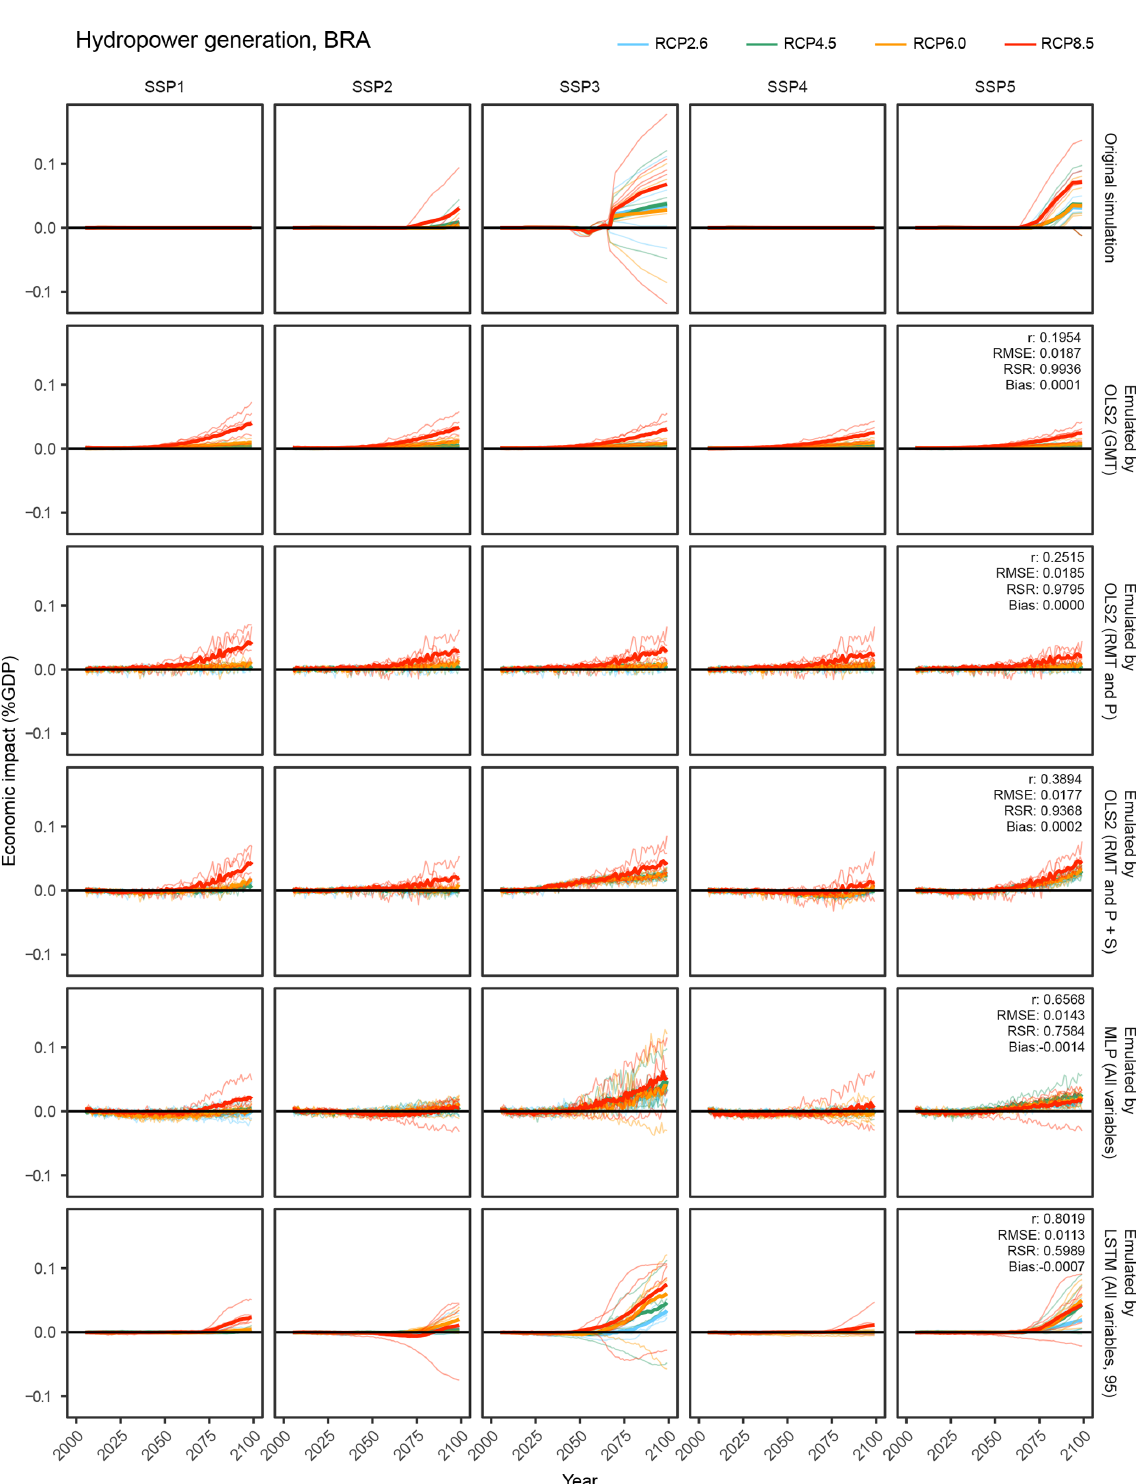
Figure 10. Time-series results of the simulation and emulations for the hydropower generation sector in the Brazil region. OLS2 (GMT): OLS2 with global mean temperature. OLS2 (RMT and P): OLS2 with regional mean temperature and precipitation. OLS2 (RMT and P + S): OLS2 with regional mean temperature precipitation and socioeconomic variables. MLP (All variables): MLP with all the input variables. LSTM (All variables, 95): LSTM with all the input variables for 95 years. Thin lines represent individual GCM results, and bold lines represent average of five